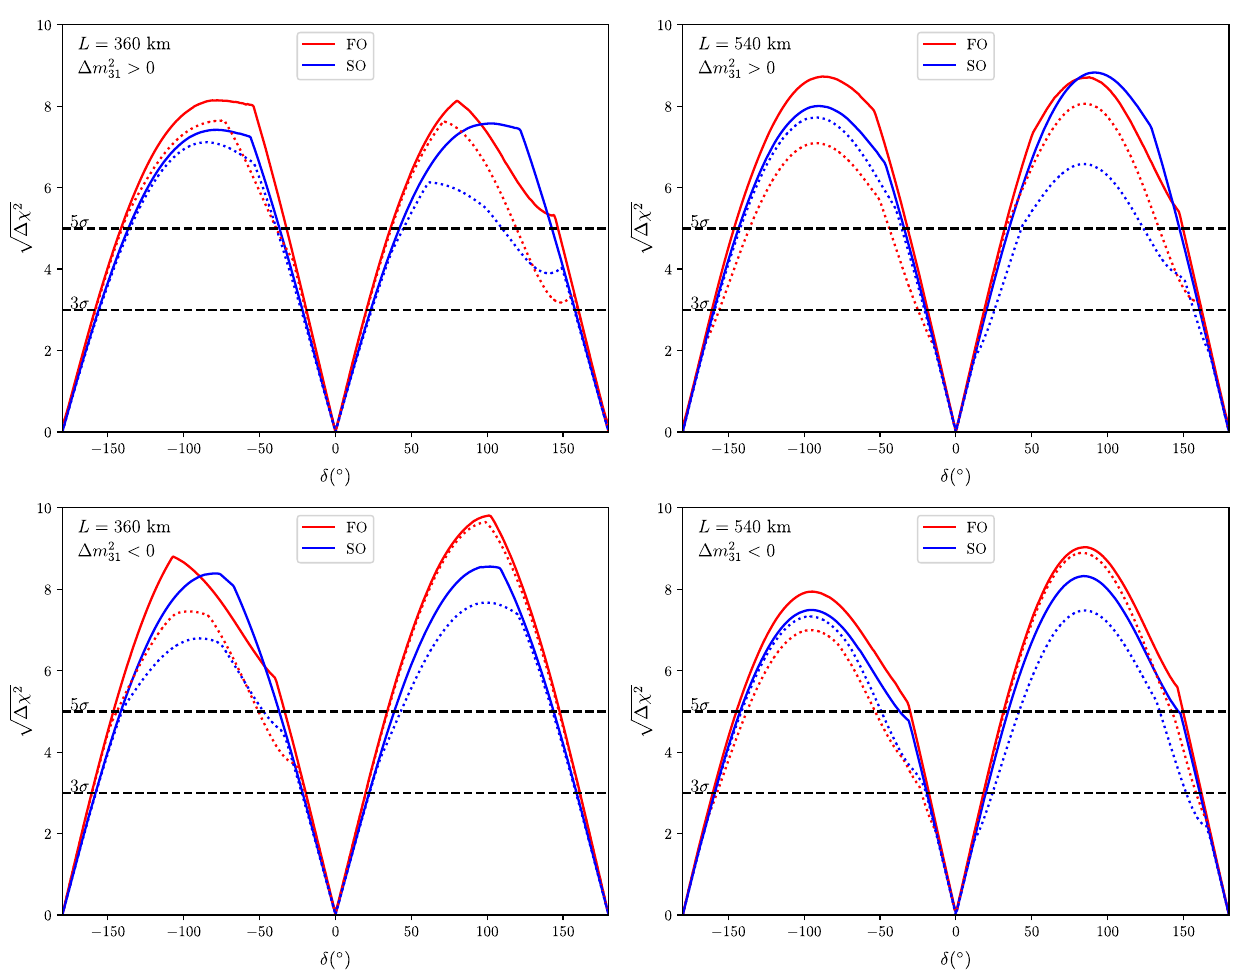
Fig. 4 Significance with which CP conserving values of δ can be excluded for the Zinkgruvan 360 km (left panels) and Garpenberg 540 km (right panels) options. The upper (lower) plots are for nor- mal (inverted) mass ordering while the red (blue) curves correspond